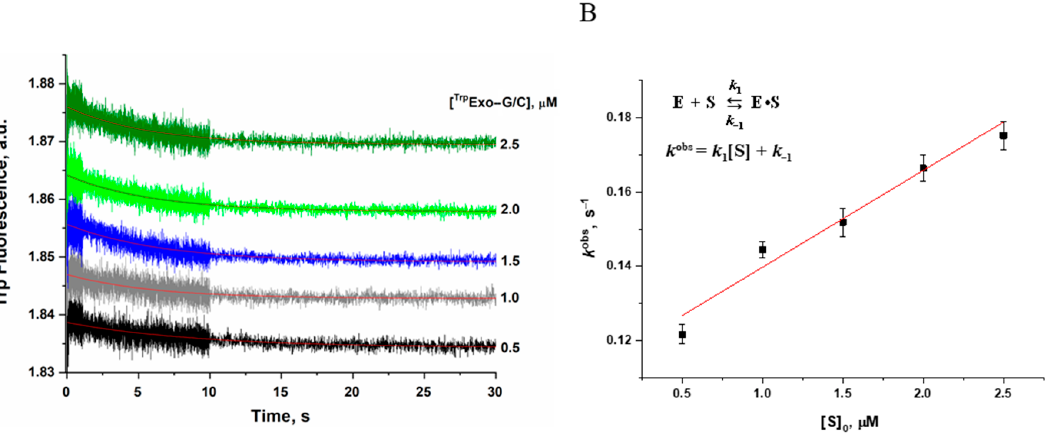
Figure 6. ( A ) The dependence of the fluorescence signal of Trp residues of Apn2 during its interaction with Trp Exo–G/C on the DNA substrate concentration, which was varied from 0.5 to 2.5 μ M. ( B ) Dependence of the observed rate constant ( k obs ) on the concentration of DNA substrate Trp Exo–G/C ([Apn2] = 2 μ M, Т = 37 °C).